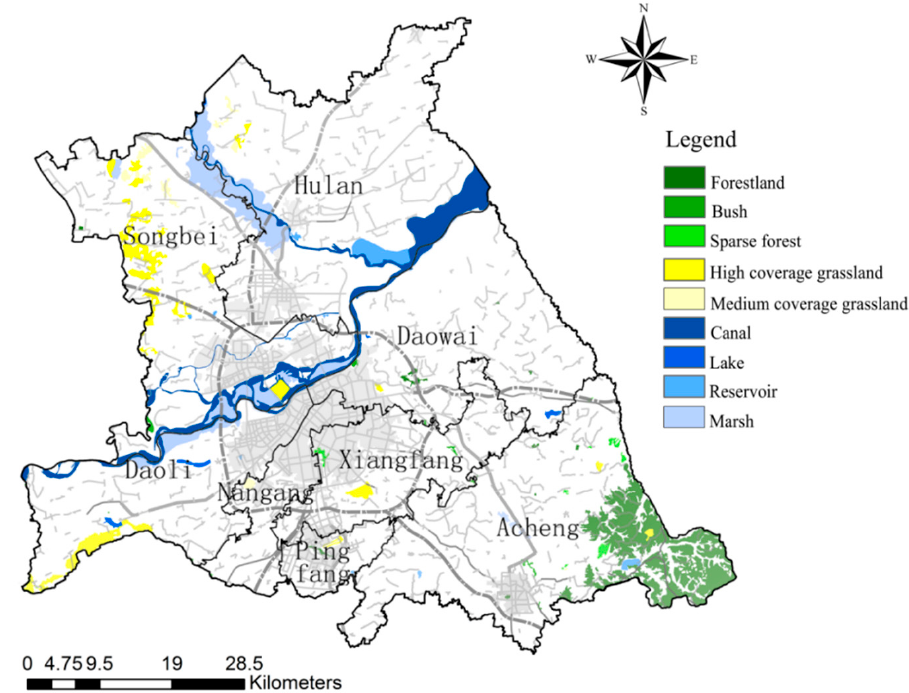
Figure 4. The ecological sources in study the area.